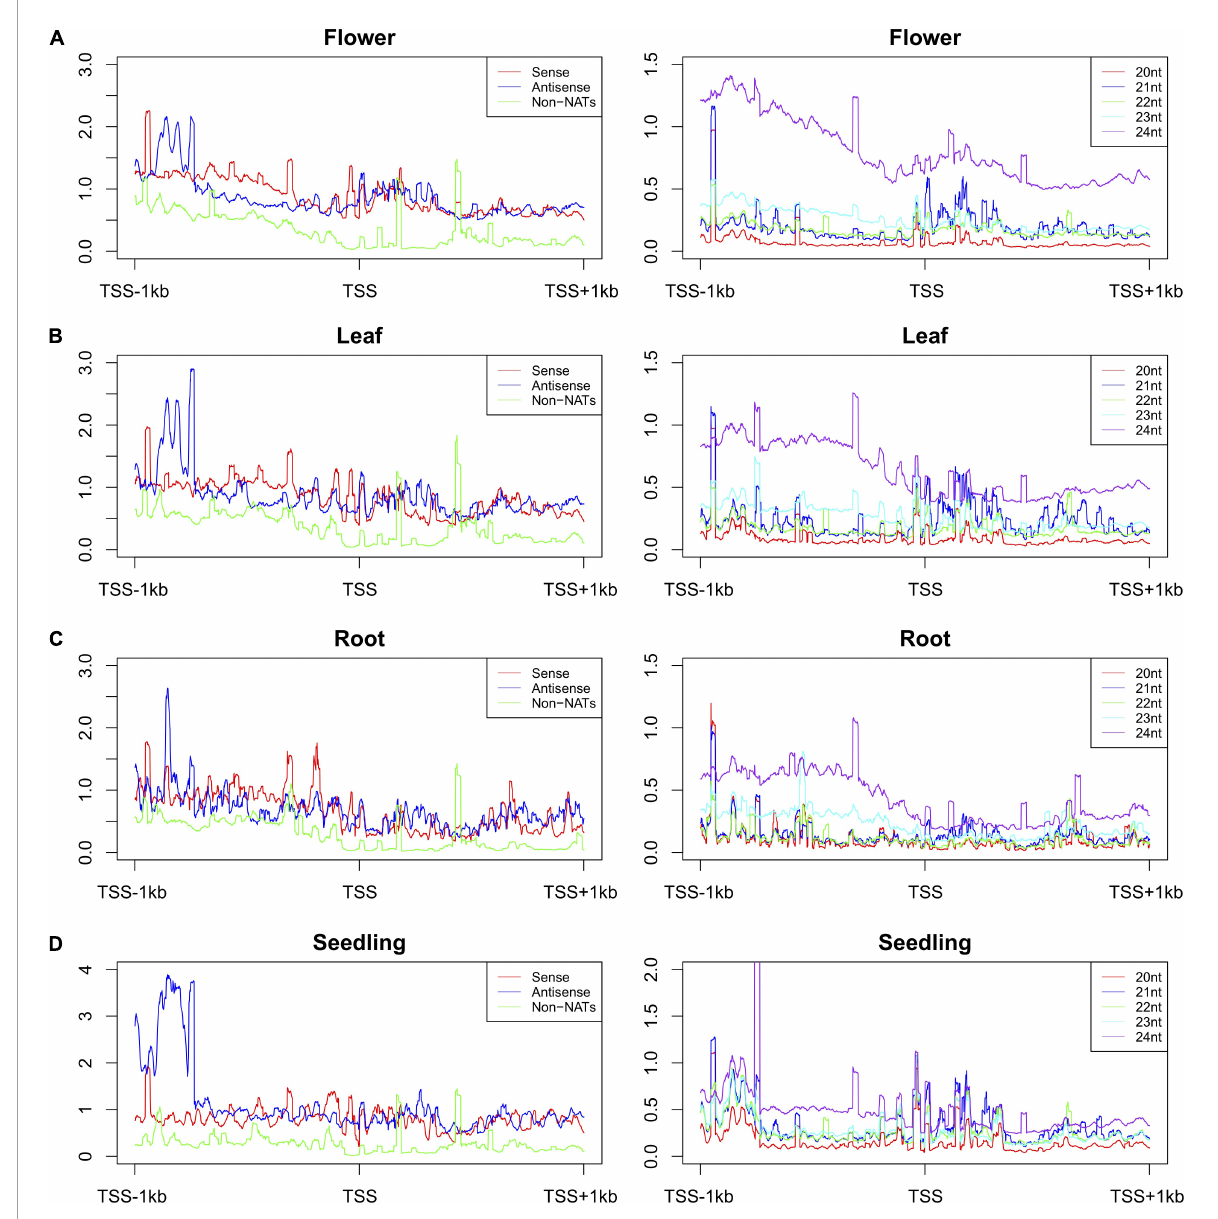
FIGURE7 Distribution of small RNAs in flower (A) , leaf (B) , root (C) , and seedling (D) around transcription start sites ( ± 1000-bp) of sense and antisense genes of NATs and non-NAT